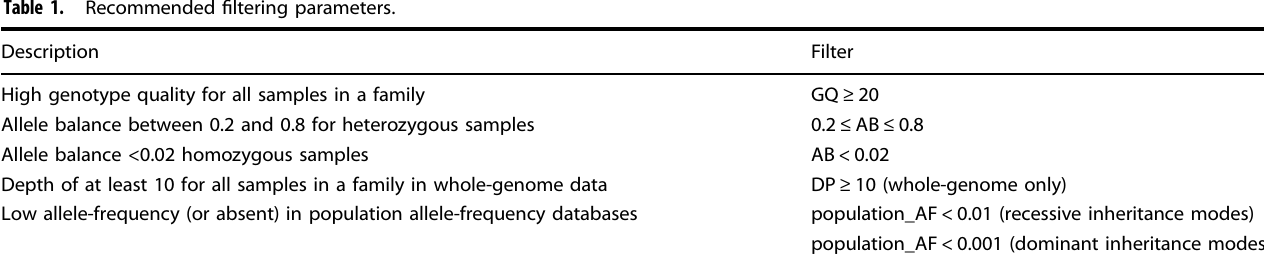
Fig. 5 The number of candidate variants that follow different inheritance modes per genome using two different variant callers. A Only “ impactful ” variants as determined by slivar using annotations from VEP, snpEff, or bcftools are shown. B The set of variants is extended to include synonymous, UTR, and conserved intron regions (but not all intronic). Counts for autosomal dominant variants are shown in a separate plot due to the much larger numbers. Each dot represents the number of candidate variants ( y -axis) passing the inheritance mode ( x - axis), genotype-quality, population allele-frequency, and allele-balance fi lters for a single family. Gray bars indicate the mean number for each class and inheritance mode. We show Fig. 5A for the sarcoma replication cohort in Supplementary Fig. 14. Table 1. Recommended fi ltering